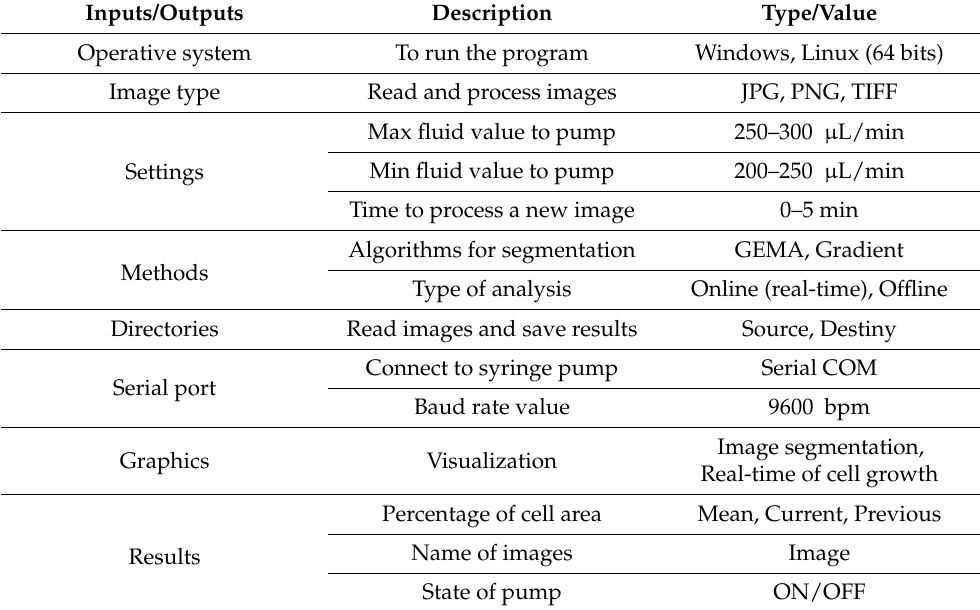
Table 4. A general description of the ANSIS Real-time control